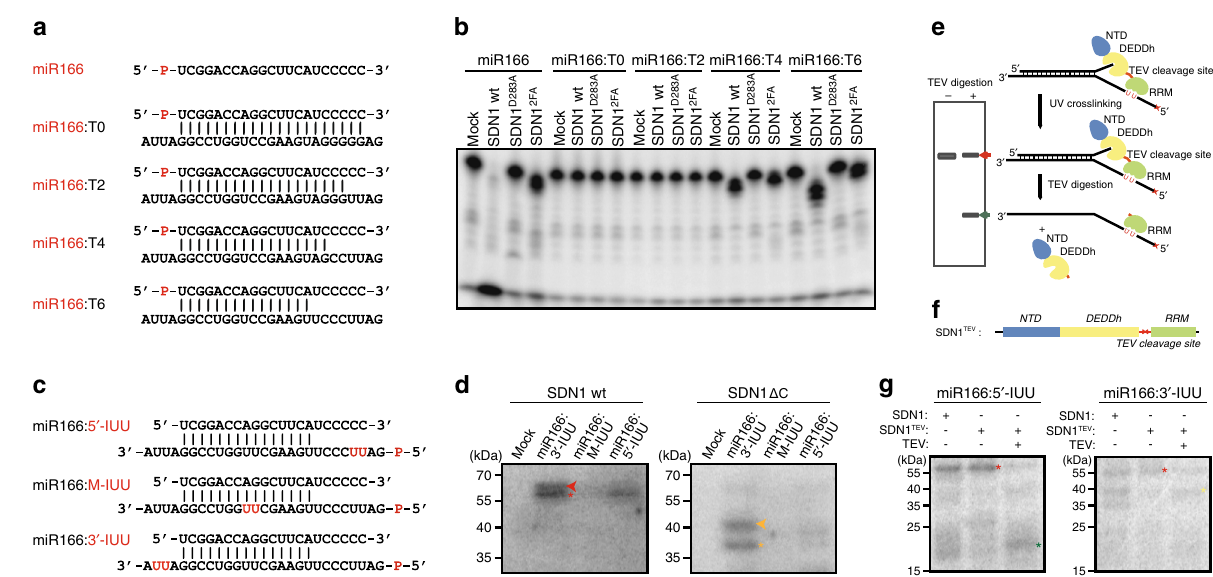
Fig. 5 The SDN1 CTD binds 5 ′ region of target strands in cooperation with 3 ′ end recognition of miRNAs by the DEDDh domain. a Diagram of various dsRNAs used as substrates in SDN1 enzymatic assays. The miR166 strands were 5 ′ end 32 P-labeled. b In vitro enzymatic assays with wild-type SDN1, the catalytic mutant SDN1 D283A and the RRM mutant SDN1 2FA on RNA duplexes. All reactions were carried out in the presence of Mg 2 + . After the reactions, RNAs were denatured and resolved on denaturing polyacrylamide gels to detect the miR166 strand. c Diagram of various dsRNAs used in UV crosslinking assays. MiR166 is shown as the upper strand and all the target RNAs were 5 ′ 32 P-labeled. Target RNAs were 5-iodoU modi fi ed at different positions as indicated in red. d UV crosslinking assays of wild-type SDN1 or SDN1 Δ C with the dsRNAs shown in c . The proteins were resolved on SDS-PAGE gels and visualized by autoradiography (from the 32 P-label). Bands representing full-length SDN1 crosslinked to dsRNA (left panel) and SDN1 Δ C crosslinked to dsRNA (right panel) are indicated by red and orange arrowheads, respectively. The lower bands indicated by asterisks were likely crosslinking products of SDN1 proteins and ssRNAs that denatured from dsRNAs during electrophoresis. e Schematic diagram of the UV crosslinking assay to map the RNA- contacting domain of SDN1. SDN1 proteins were fi rst UV crosslinked to RNAs, followed by TEV digestion and SDS-PAGE electrophoresis. The RNA- contacting domain of SDN1 is deduced by the size of the protein fragment marked by the 32 P-labeled RNA. f Diagram of the SDN1 TEV protein. The TEV cleavage site was inserted between the DEDDh and RRM domains. g UV crosslinking of SDN1 TEV and dsRNAs followed by TEV digestion. The dsRNAs used are as indicated above the gels. Crosslinking of SDN1 or SDN1 TEV with the same RNAs but without TEV digestion was included to indicate the size of the full-length SDN1-RNA adduct (indicated by red asterisks). Cleaved SDN1 TEV bands at the size of the RRM domain (5-IUU RNA duplex), or at the size